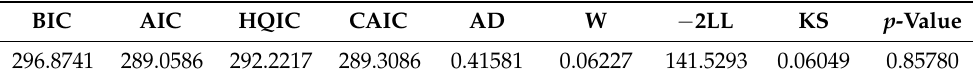
Table 8. The BIC, AIC, HQIC, CAIC, AD, W, KS , and − 2LL for the carbon fibers data. BIC AIC HQIC CAIC AD W − 2LL KS p